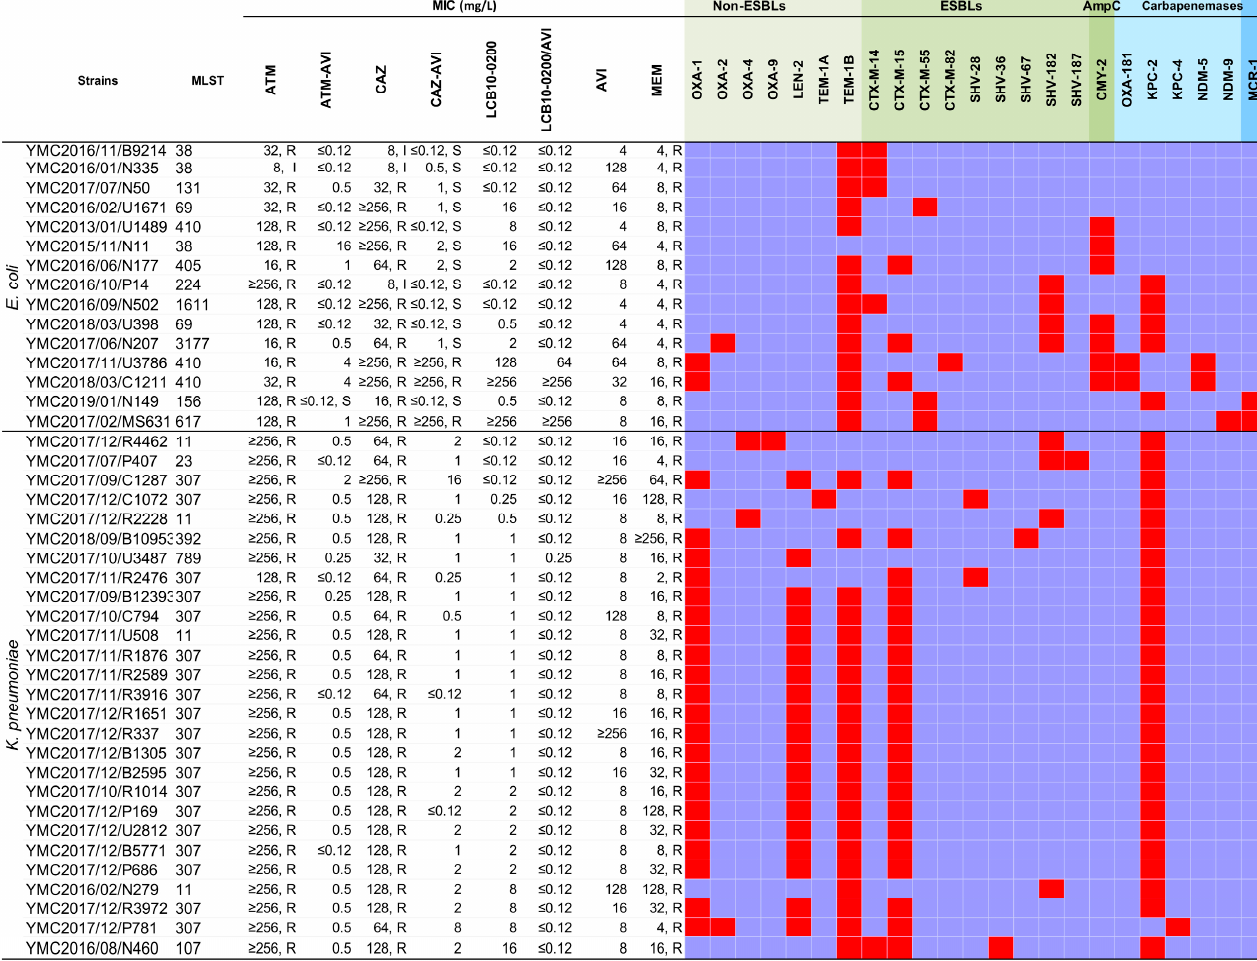
Figure 1. Antibiotic susceptibility and resistome of the carbapenem-resistant E. coli and K. pneumoniae strains.Abbreviation: ATM, aztreonam; AVI: Avibactam; ATM-AVI: aztreonam/avibactam; CAZ, ceftazidime; CAZ-AVI, ceftazidime/avibactam; MEM, meropenem; ESBL, Extended-spectrum β -lactamase. Antibiotic susceptibility testing was performed using agar dilution method. Data were interpreted using the Clinical and Laboratory Standards Institute guidelines M100 28th ed. The orchid and red color indicate the absence and presence of antimicrobial resistance genes, respectively. The very light green, light green, green, light blue indidate β -lactamses belonging to Non-ESBLs, ESBLs, AmpC, and carbapenemases. The blue indicates colisin-resistant enzyme